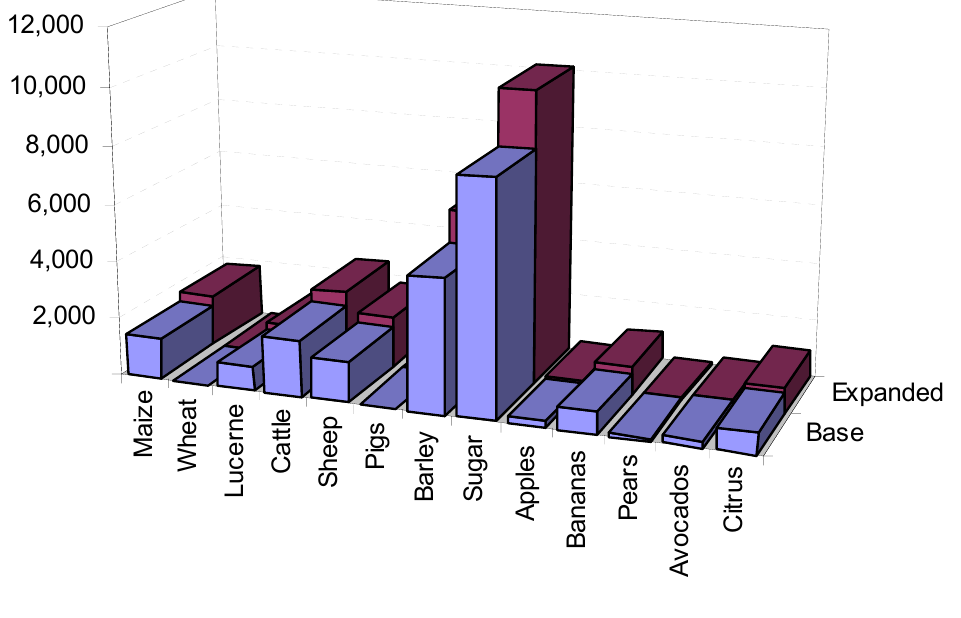
Figure 11- Land allocations for expanded and base